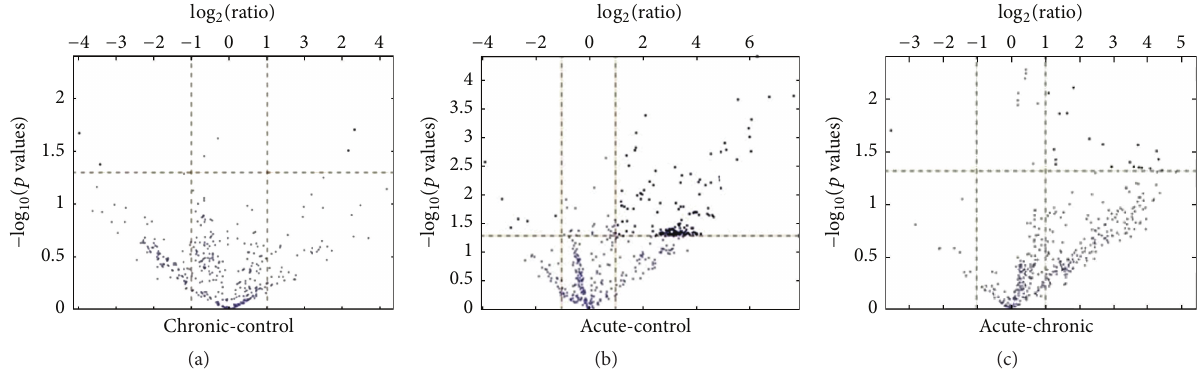
Figure 1: Differential expressions of miRNAs evaluated in (a) chronic versus control, (b) acute versus control, and (c) chronic versus acute cases depend on mRNA microarray analysis ( 𝑝 < 0.05 , cut-off = 2). The volcano plot demonstrates the differential expression of the illustrated genes; dots in light represent genes that did not achieve significant changes in expression, dots in the dark on the left indicate the genes with significantly downregulated expression, and dots in the dark on the right indicate the genes with significantly upregulated expression. Table 1: List of significantly altered miRNA expressions in both chronic and acute brucellosis cases. Chronic versus control Acute versus miRNA name